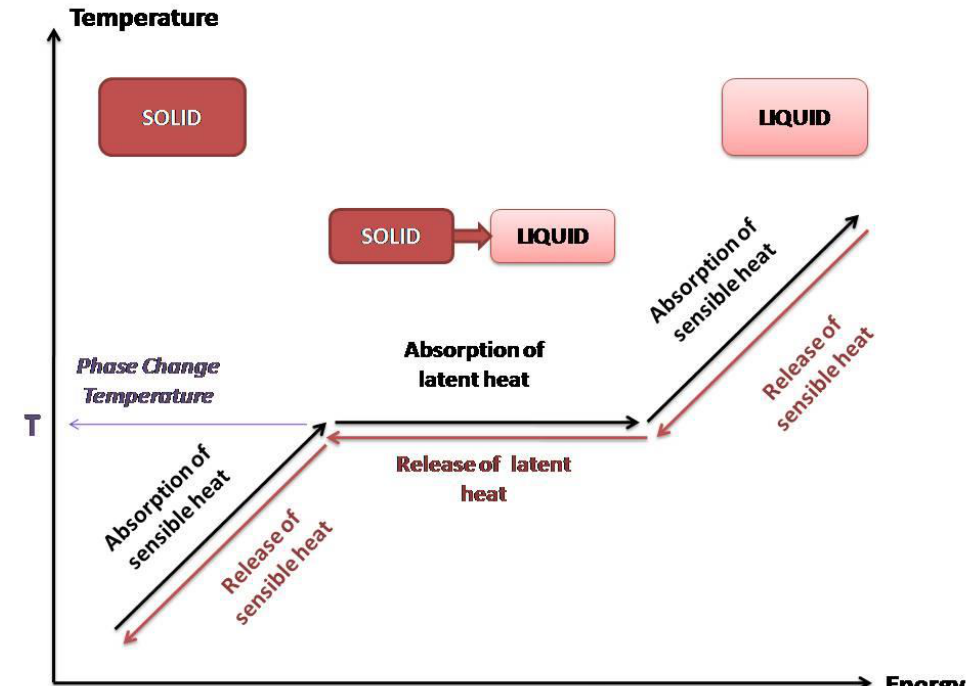
Figure 2. Sensible and latent heat.